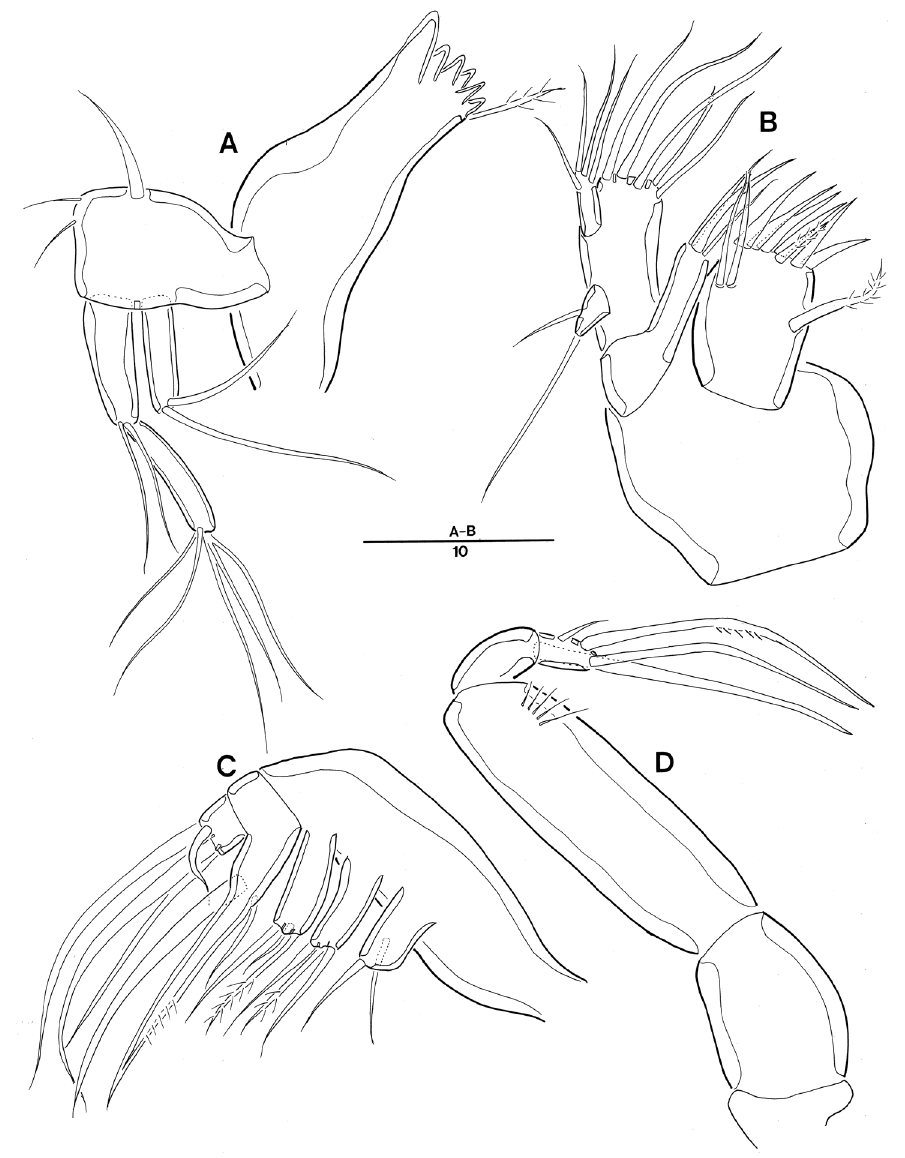
Figure 3. Leptopsyllus ( Leptopsyllus ) pundius sp. n. ( ♀ ). A mandible B maxillule C maxilla D maxilliped. Scale bars are in